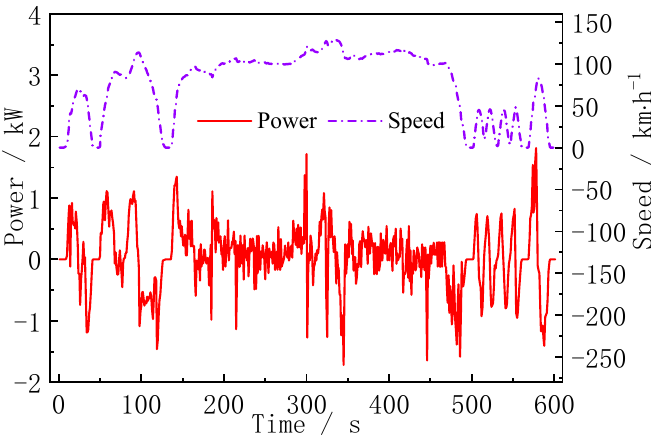
Figure 7. The speed and power of the US06 test process.